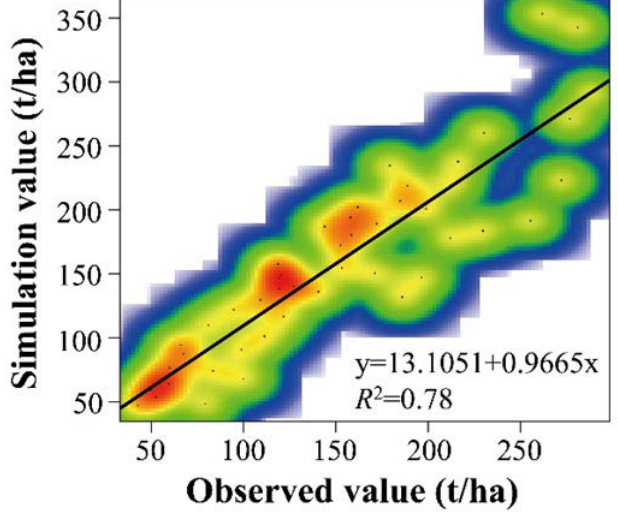
Figure 3. Comparison of observed and simulated carbon storage from the InVEST model. The ob- served carbon storage was estimated by forest inventory data conducted in 2020.